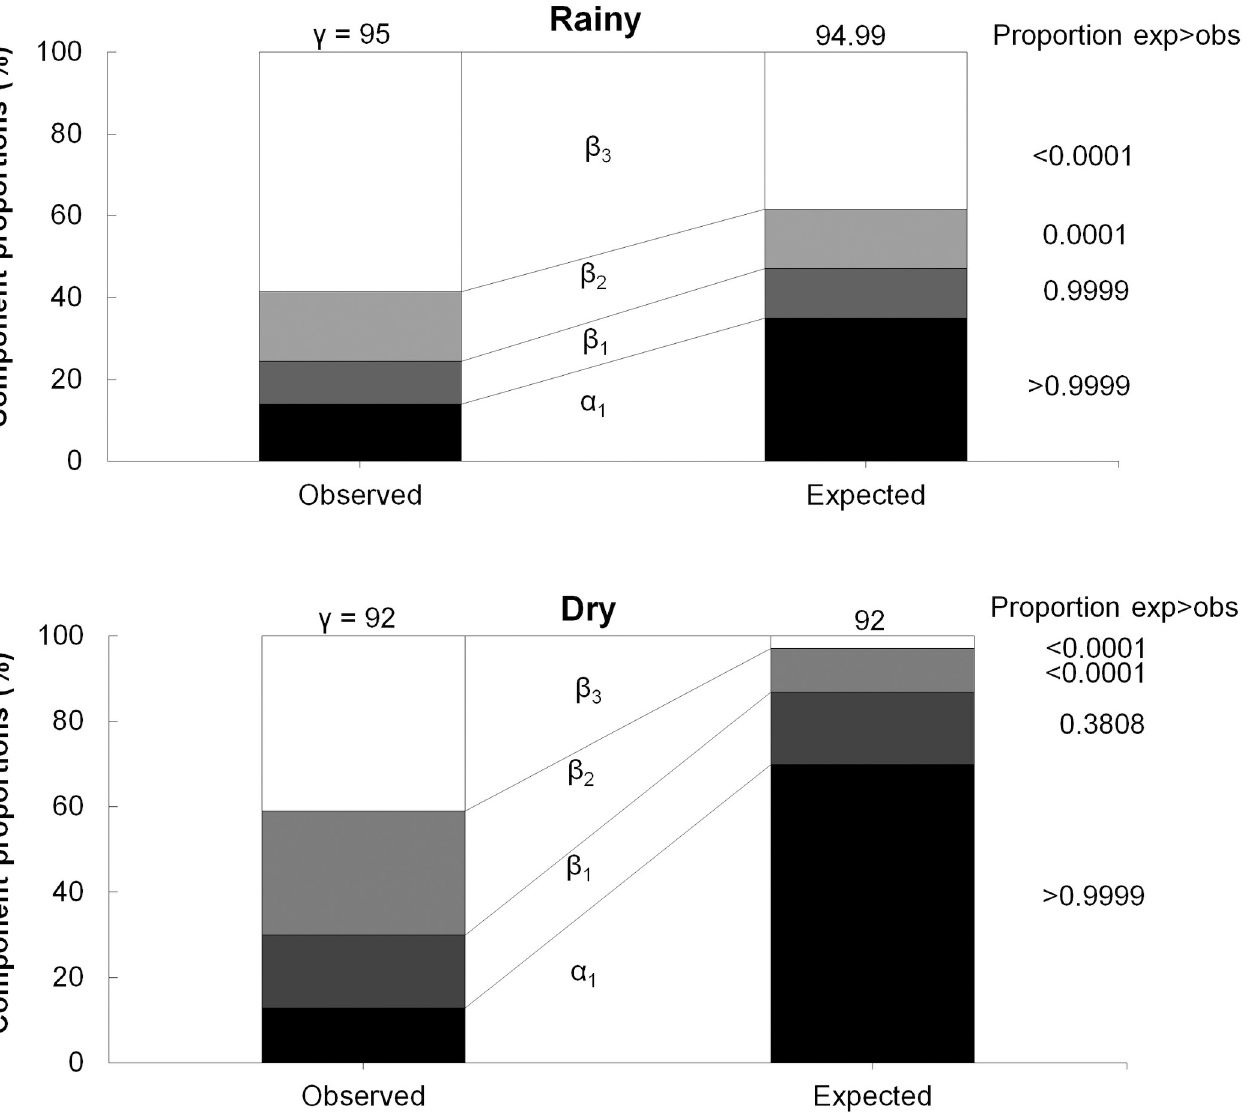
Fig 2. γ -diversities additively partitioned into β - and α -diversities with observed and expected significance. γ -diversity = regional diversity from estuary during rainy and dry seasons, β 3 -diversity = diversity among zones, β 2 -diversity = diversity among point sites, β 1 -diversity = diversity among sampling sites and α 1 -diversity = diversity within sampling